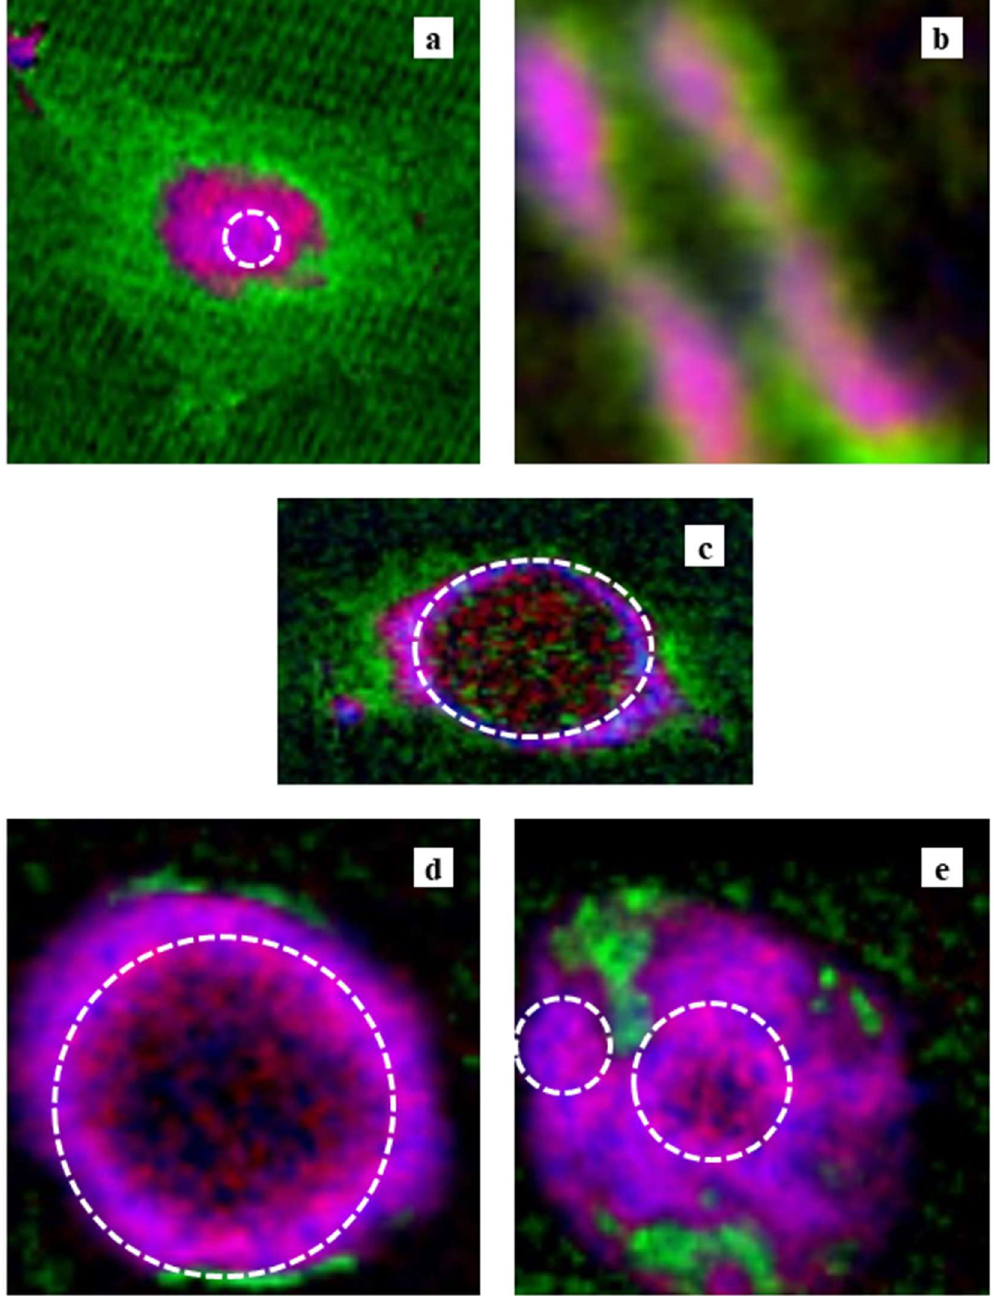
Figure 8. RGB expression of the images of the ( a ) CHO cell, ( b ) chromosome, ( c ) HeLa S3 cell, ( d ) isolated nucleus, and ( e ) apoptotic nucleus. DNA, RNA, and histone are displayed as red, green, and blue, respectively. Areas possibly unreliable for the analysis are encircled by dashed